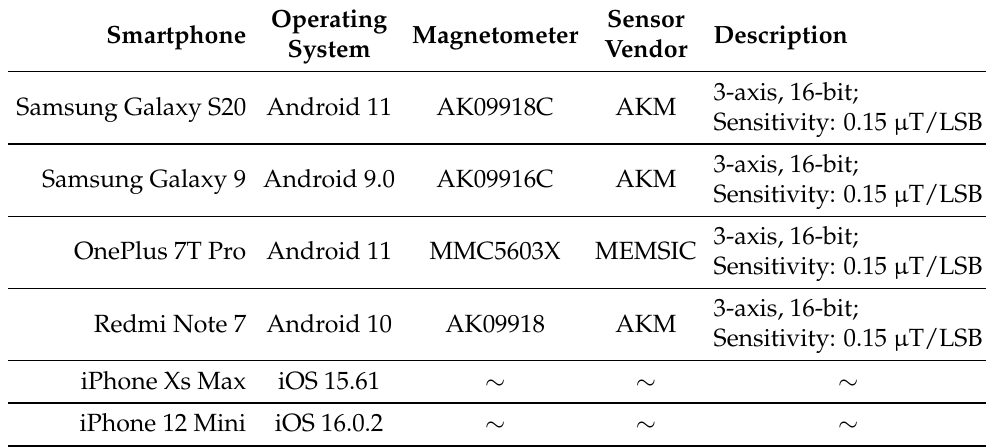
Table 1. Magnetometer information and operating systems for heterogeneous smartphones. Operating Smartphone